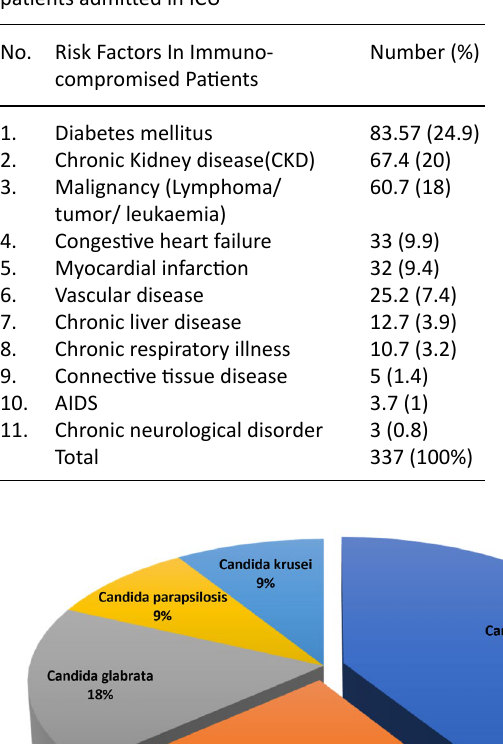
Table 3. Incidence of risk factors in immunocompromised patients admitted in ICU